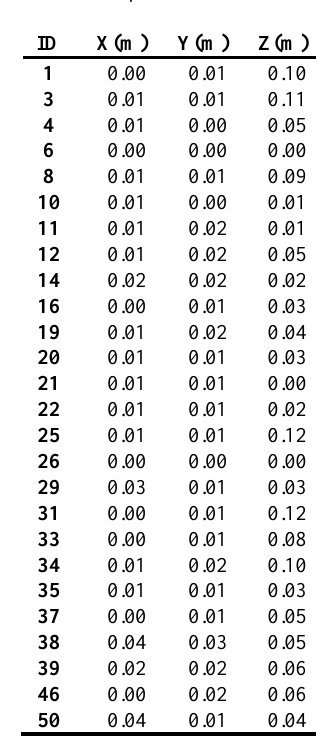
Figure 9. Accuracy check on 26 CPs when testing the GCPs method. Numbers correspond to the CPs ID. Basemap: orthophoto resulting from the photogrammetric survey performed with UAV DJI Spark.